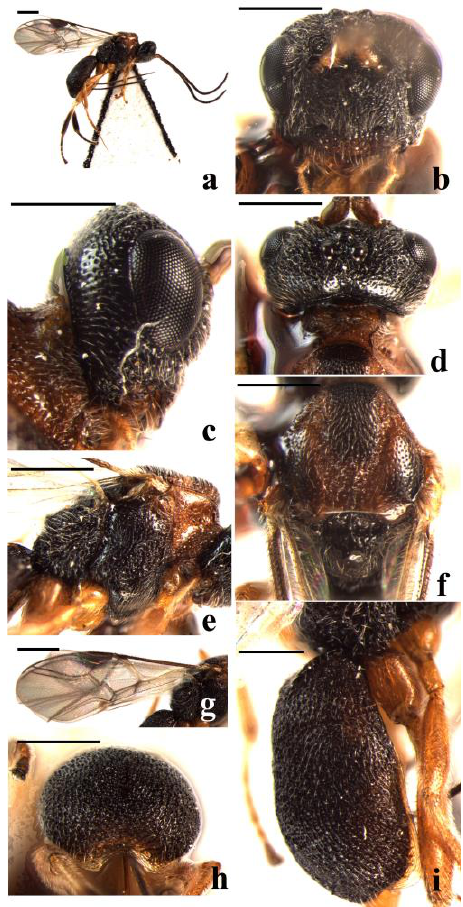
Figure 1. Schizoprymnus carinatus , sp. nov., holotype, ♀ . ( a ) Habitus, lateral aspect; ( b ) head, frontal aspect; ( c ) head, lateral aspect; ( d ) head, dorsal aspect; I mesosoma, lateral aspect; ( f ) mesoscutum, dorsal aspect; ( g ) fore wing; ( h ) posterior margin of carapace; ( i ) carapace, lateral aspect. Scale bar: 1 mm. Wings. Fore wing: pterostigma is about 3.0 times as long as wide; 1-R1 1.2 times as long as pterostigma; r:3-SR + SR1:2-SR = 12:75:20; 1-SR + M smoothly curved; SR1 strongly curved; cu-a postfurcal; m-cu antefurcal. Hind wing: 1-M:1r-m = 30:21; M + CU:1-M = 30:41; cu-a